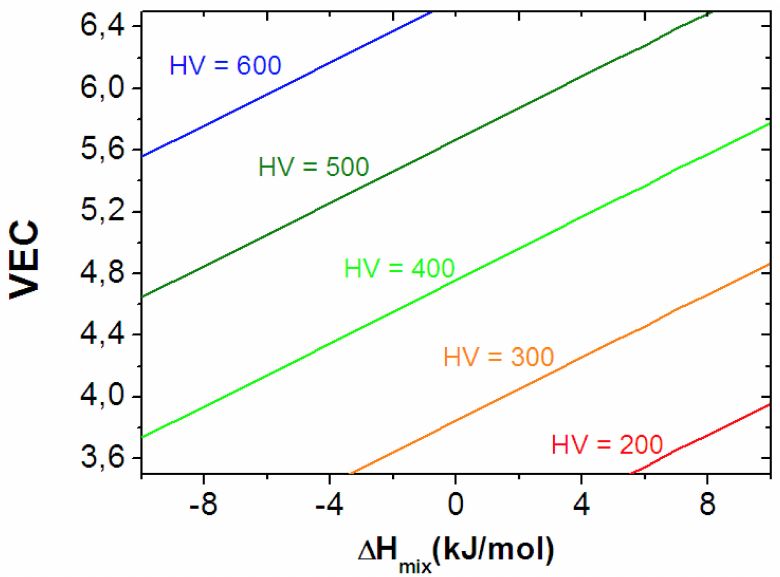
Figure 7. Relationship between HV and bond parameters for ETM–RHEAs, indicated by linear VEC- ∆ H mix functions obtained at different HV